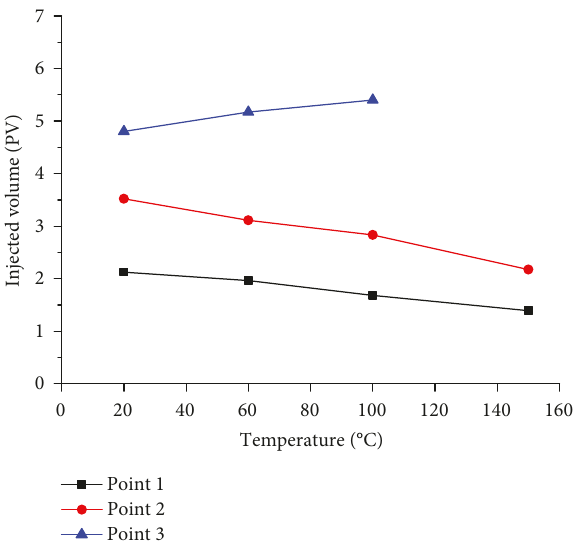
Figure 5: Pressure distribution along the sandpack under steady state at di ff erent temperatures.